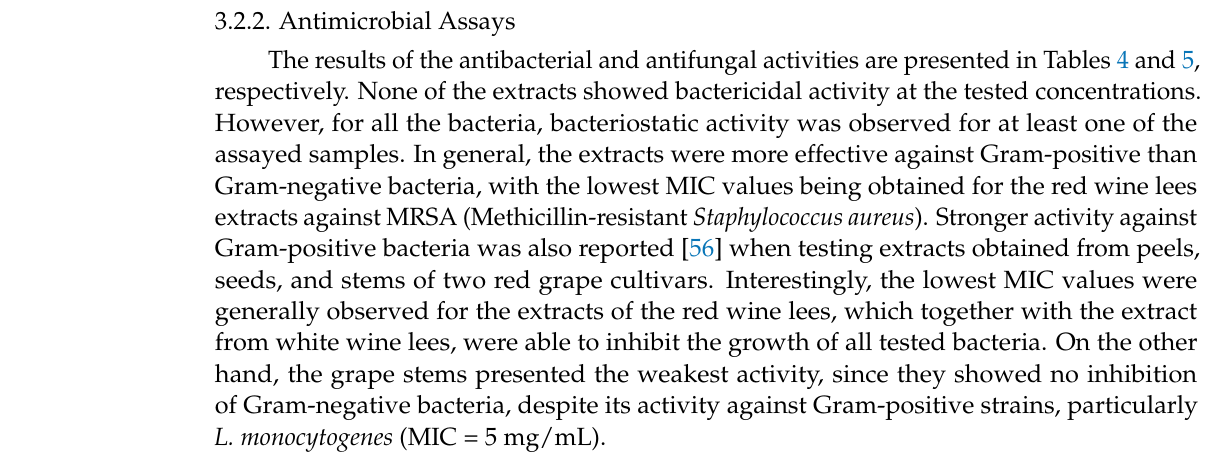
Table 4. Antimicrobial activity of hydroethanolic extracts (mg/mL) obtained from winemaking residues from the harvest of